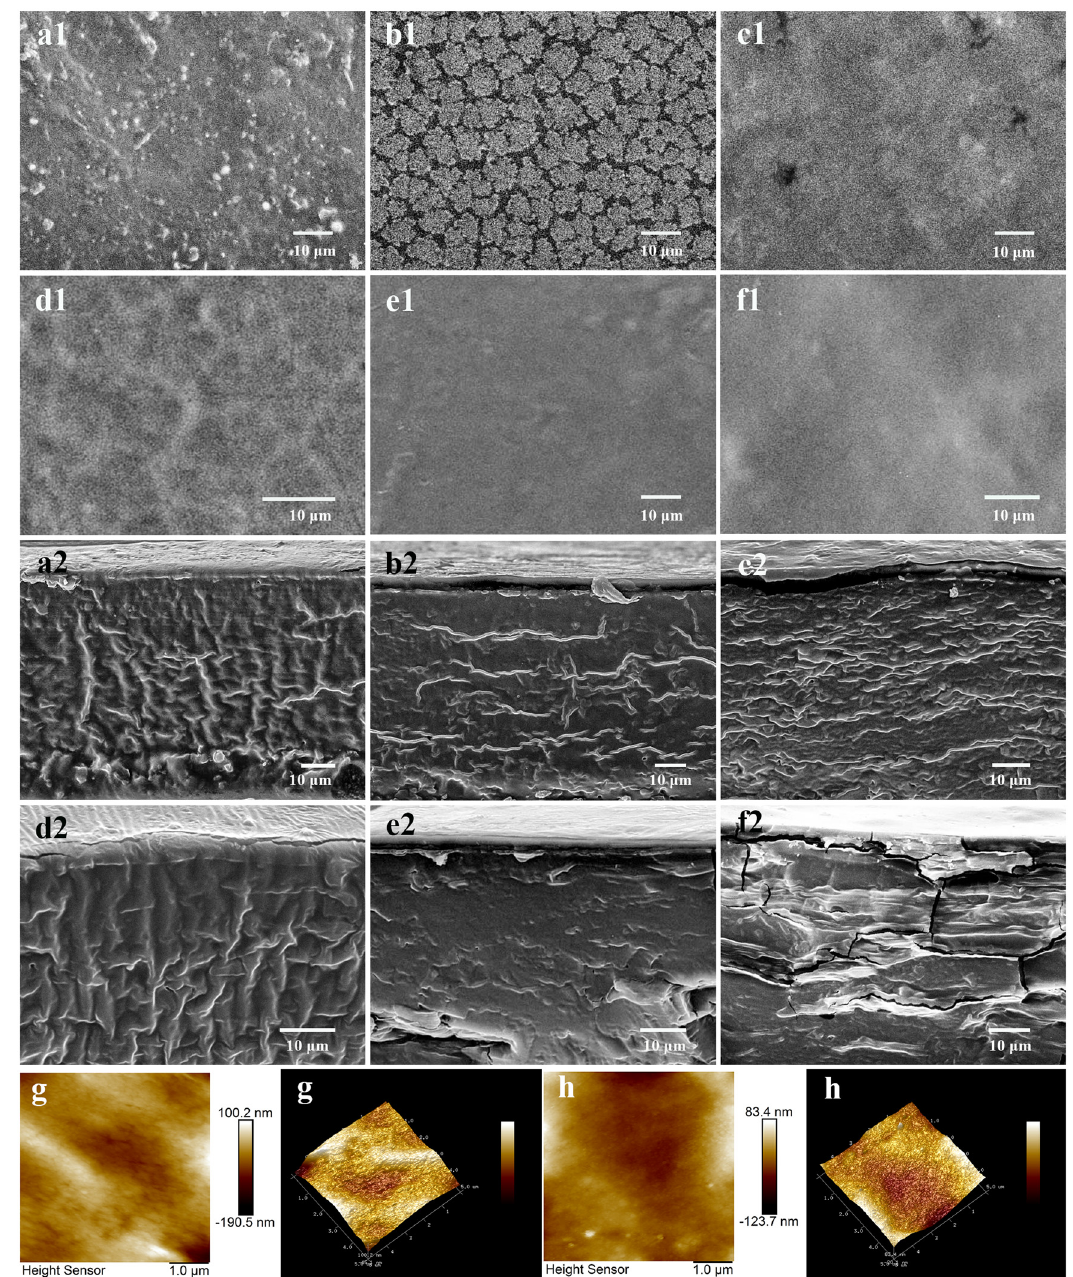
Figure 3: SEM and AFM images of LR and IPN fi lms: surface of LR ( a1 ) , IPN10 ( b1 ) , IPN20 ( c1 ) , IPN30 ( d1 ) , IPN40 ( e1 ) , and IPN50 ( f1 ) fi lms at 1,000 × magni fi cation; cross - section of LR ( a2 ) , IPN10 ( b2 ) , IPN20 ( c2 ) , IPN30 ( d2 ) , IPN40 ( e2 ) , and IPN50 ( f2 ) fi lms at 1,000 × magni fi cation. AFM image ( plane and 3D ) of LR ( g ) and IPN30 ( h ) fi